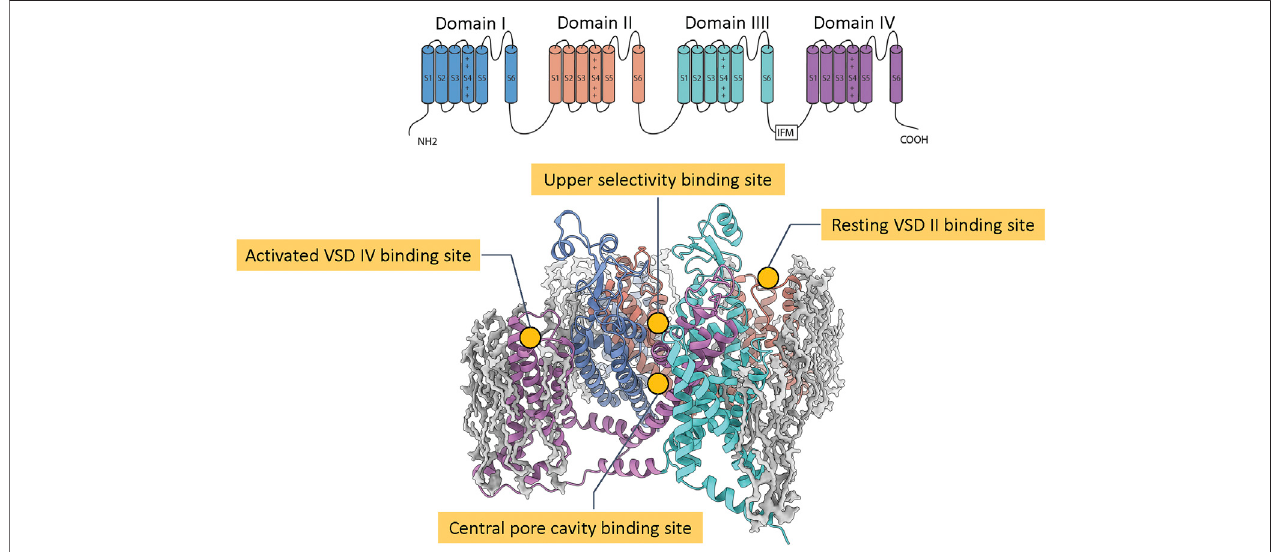
FIGURE 1 | Notable pharmacological binding sites on Na V channels. The top panel shows the transmembrane topology of a eukaryotic Na V channel with four homologous domains and six transmembrane segments S1 to S6. The bottom panel shows a structure of a Na V channel (colored ribbons) with four common pharmacological binding sites (labeled) embedded in a lipid patch (gray blobs).